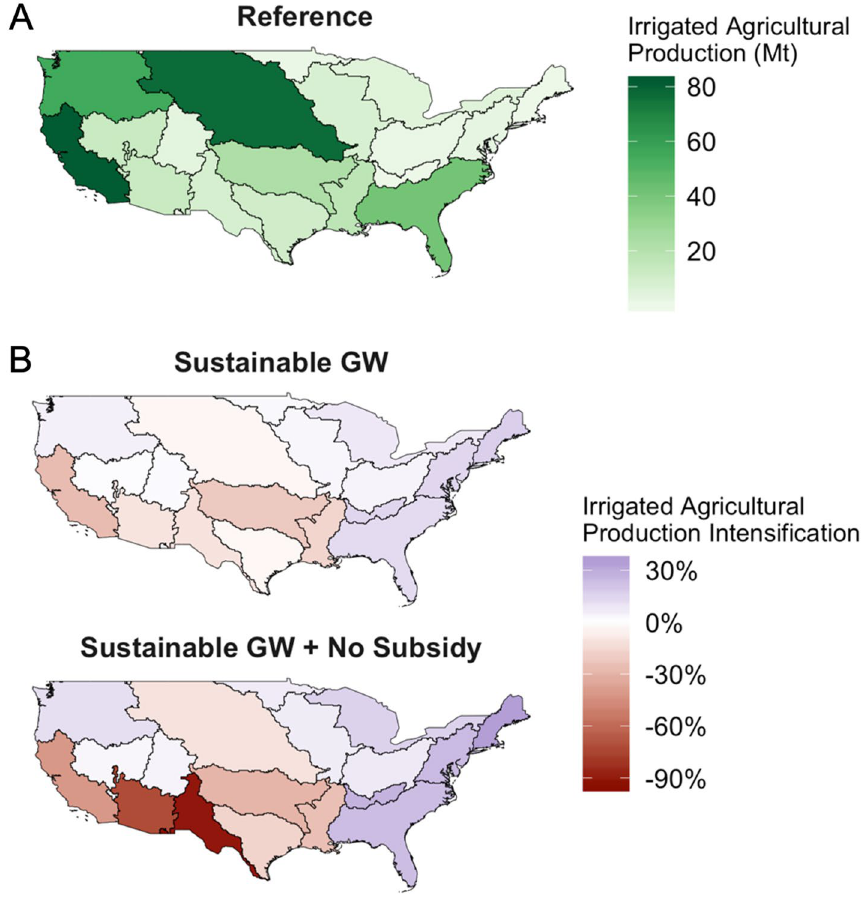
Figure 2. Impacts to end of century irrigated agricultural production across two extremes of future water use. (A) Irrigated agricultural production in 2100 for the Reference scenario. ( B) Relative agricultural production losses and gains in 2100 in the two test